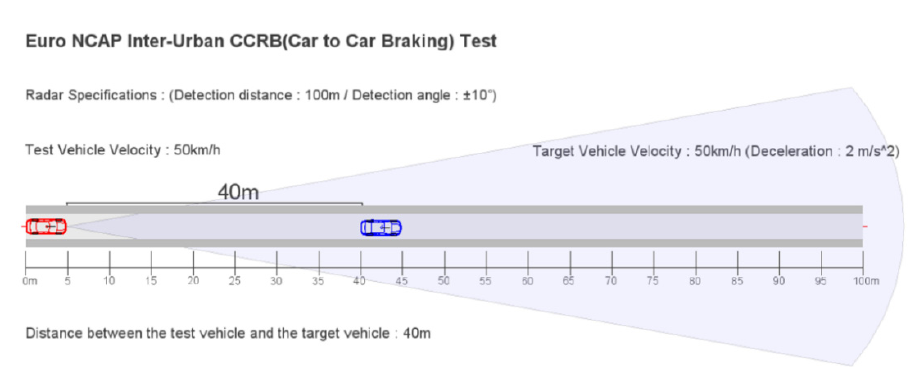
Figure 10. Euro NCAP city scenario.